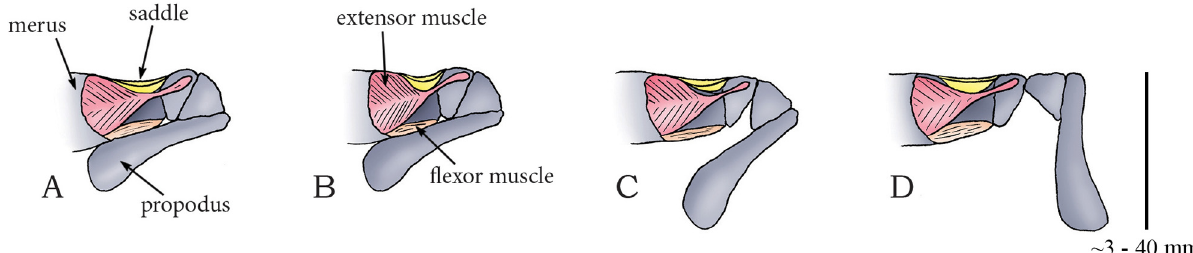
Fig 25. Linkage and latch catapult mechanism in the phylum Stomatopoda (species Odontodactylus scyllarus ). (A) The appendage of the mantis shrimp consisting of a saddle-shaped elastic structure located between the merus and the propodus. (B) Compression of the saddle and latching of the propodus by the simultaneous contraction of the extensor and flexor muscles. (C – D) Release of the latch by relaxation of the flexor muscle, allowing outward movement of the propodus. Drawings based on schematic drawings in [133]. Scale bar indicates the length of the propodus, which is in between 3 and 40 mm.